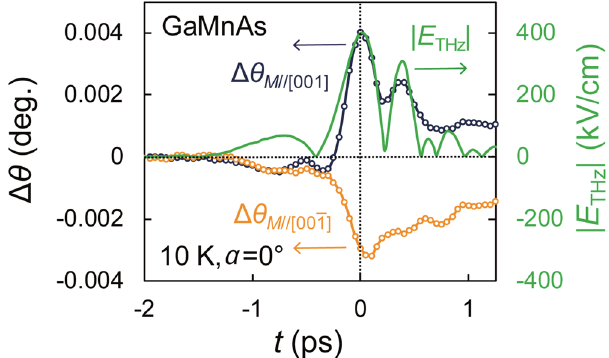
Figure 2. Terahertz response of the GaMnAs film. Blue and orange open circles represent Δ θ measured at 10 K for the Ga 0.94 Mn 0.06 As thin film when E probe // E THz ( α = 0°) with the magnetic field of 30 mT is applied in the [001] and [001] directions, respectively. | E THz | is shown by the green solid